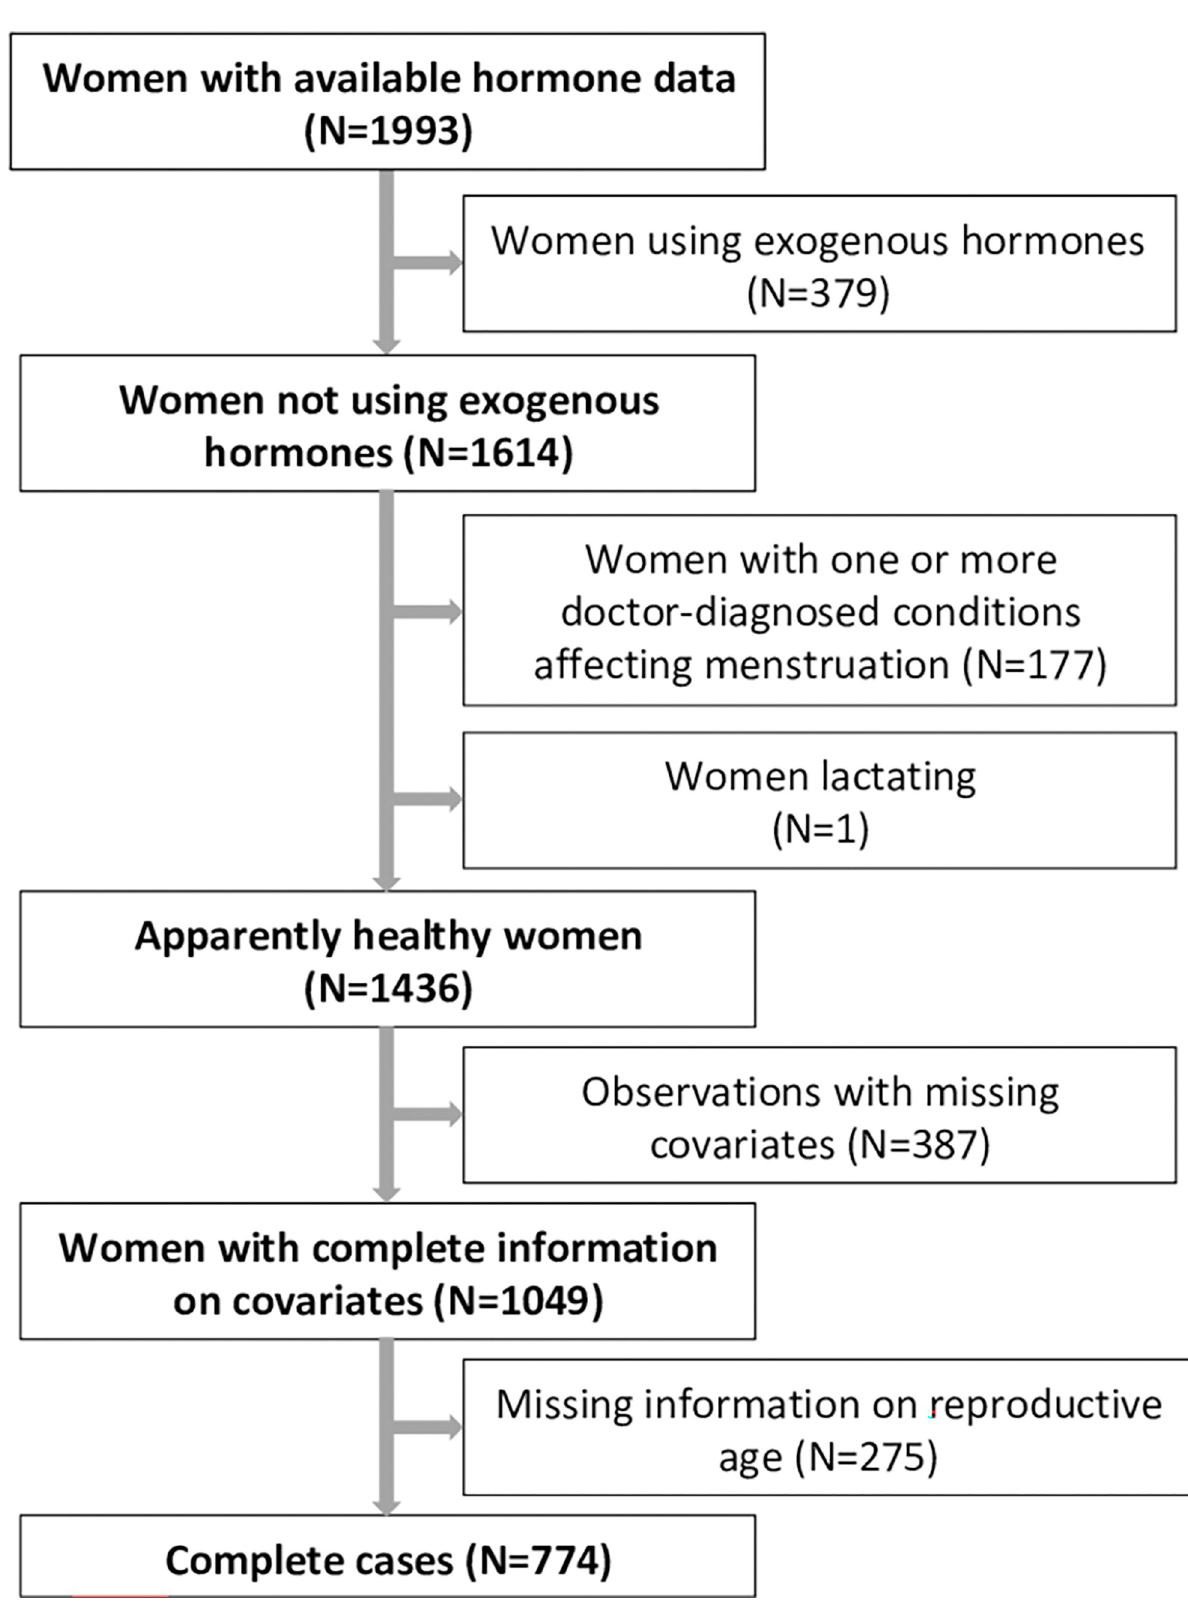
Fig 1. Flowchart of the study population with exclusion criteria. https://doi.org/10.1371/journal.pone.0269569.g001 PLOS ONE | https://doi.org/10.1371/journal.pone.0269569 June 22,